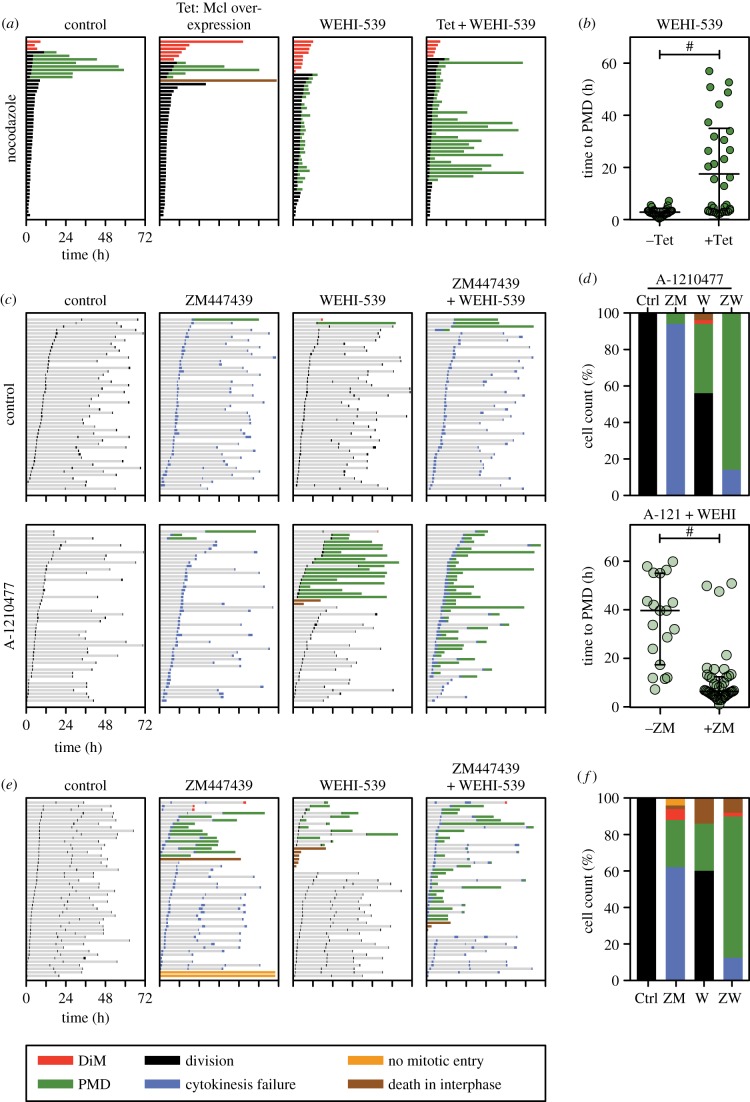
Inhibition of Mcl-1 sensitizes WEHI-539-treated cells to a mitotic driver. (a) Cell fate profiles of RKO cells treated with 20 ng ml−1 nocodazole and 100 nM WEHI-539 following induction of GFP-tagged Mcl-1 with 1 µg ml−1 tetracycline (Tet). (b) Scatter plot showing the time from mitotic exit to death for WEHI-539-treated cells in (a) that underwent PMD in the presence or the absence of overexpressed Mcl-1. #p < 0.0001. (c) Cell fate profiles of RKO cells exposed to 2 µM of the Aurora B inhibitor ZM447439, 100 nM WEHI-539 and 2 µM of the Mcl-1 inhibitor A-1210477. (d) Bar graph quantitation of (c) showing the number of cells undergoing each fate, and scatter plot quantitating the time from mitotic exit to death for the cells that underwent PMD. #p < 0.0001. (e) Cell fate profiles of DLD-1 cells exposed to 2 µM ZM447439 and 100 nM WEHI-539. (f) Bar graph quantitation of (e) showing the number of cells undergoing each fate. In panel (a), zero hours on the fate profiles represents when cells entered mitosis, while in panels (c) and (e) it corresponds to when imaging started.